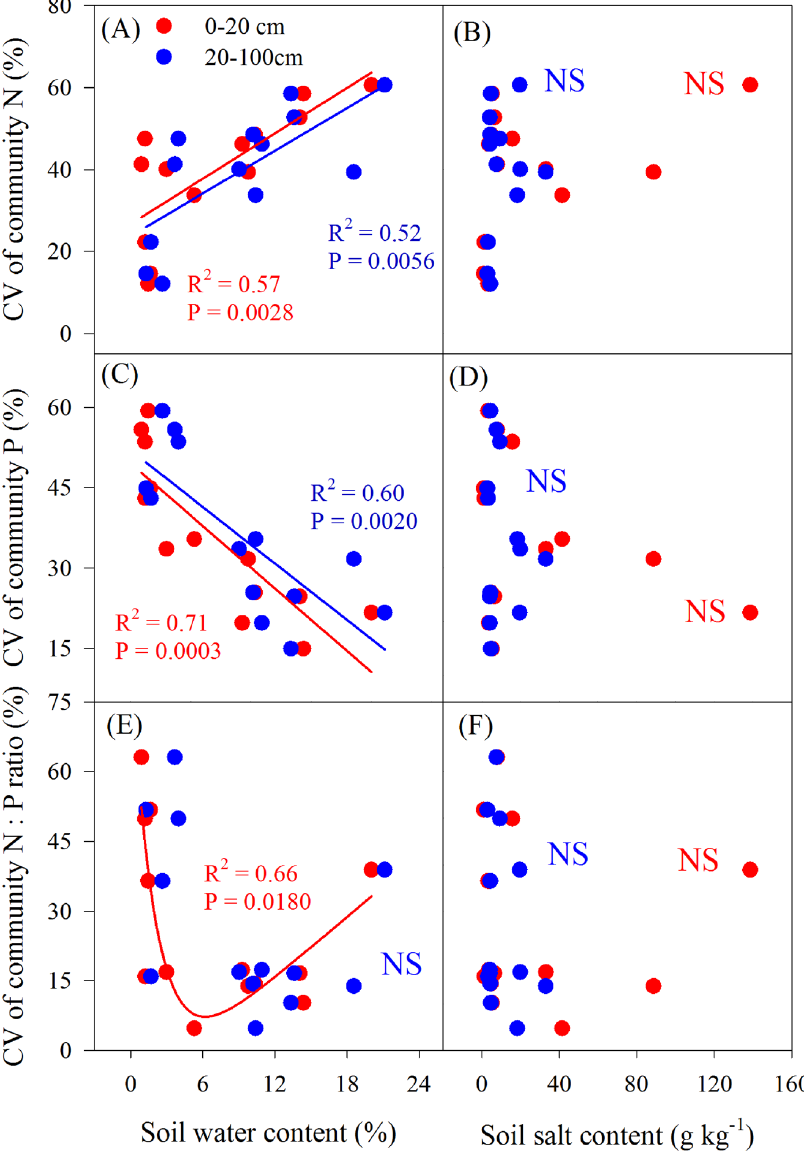
Figure 7. Relationships between the coefficient of variance (CV) of community nutrients and soil water and salt concentration.